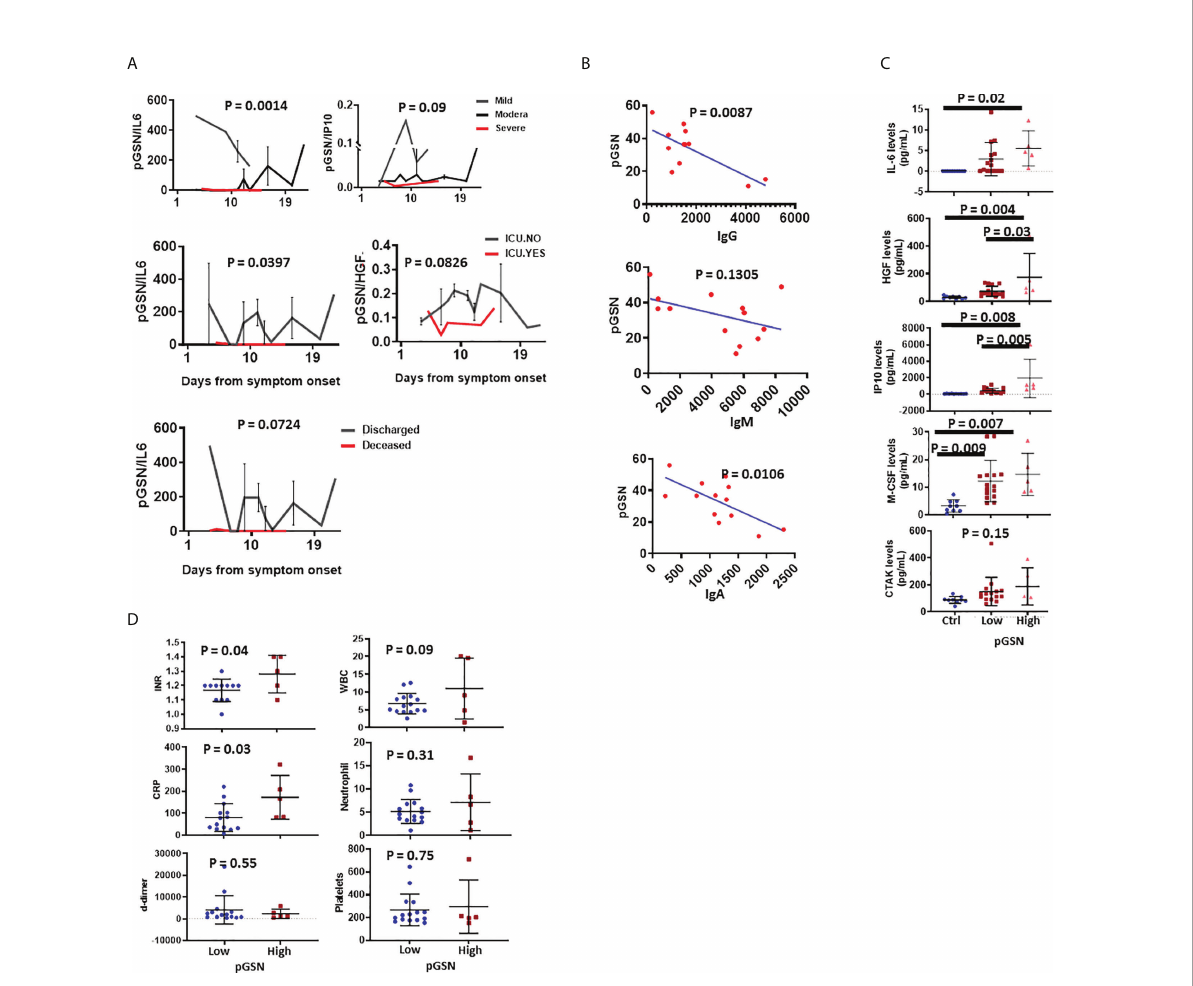
FIGURE 3 pGSN/IL-6 multi-analyte is a strong marker for monitoring disease severity and outcomes days from symptoms onset. (A) pGSN/IL-6, pGSN/IP-10 and pGSN/HGF levels were utilized to monitor disease severity, ICU admittance and discharge following day 1 from symptoms onset. (B) pGSN and SARS-COV-2 antibodies (IgG, IgM and IgA) were assessed on day 8 and correlated using Pearson ’ s test. (C) Patients were strati fi ed into low and high pGSN groups using an optimal cut-off point. The mean ± SEM levels of IL-6, HGF, IP-10, M-CSF and CTAK were compared between the groups using scatter plot. (D) The mean ± SEM levels of INR, CRP, d-dimer, WBC, neutrophils and platelets were compared between the pGSN groups using scatter plot. P-values were calculated by one-way ANOVA and independent sample